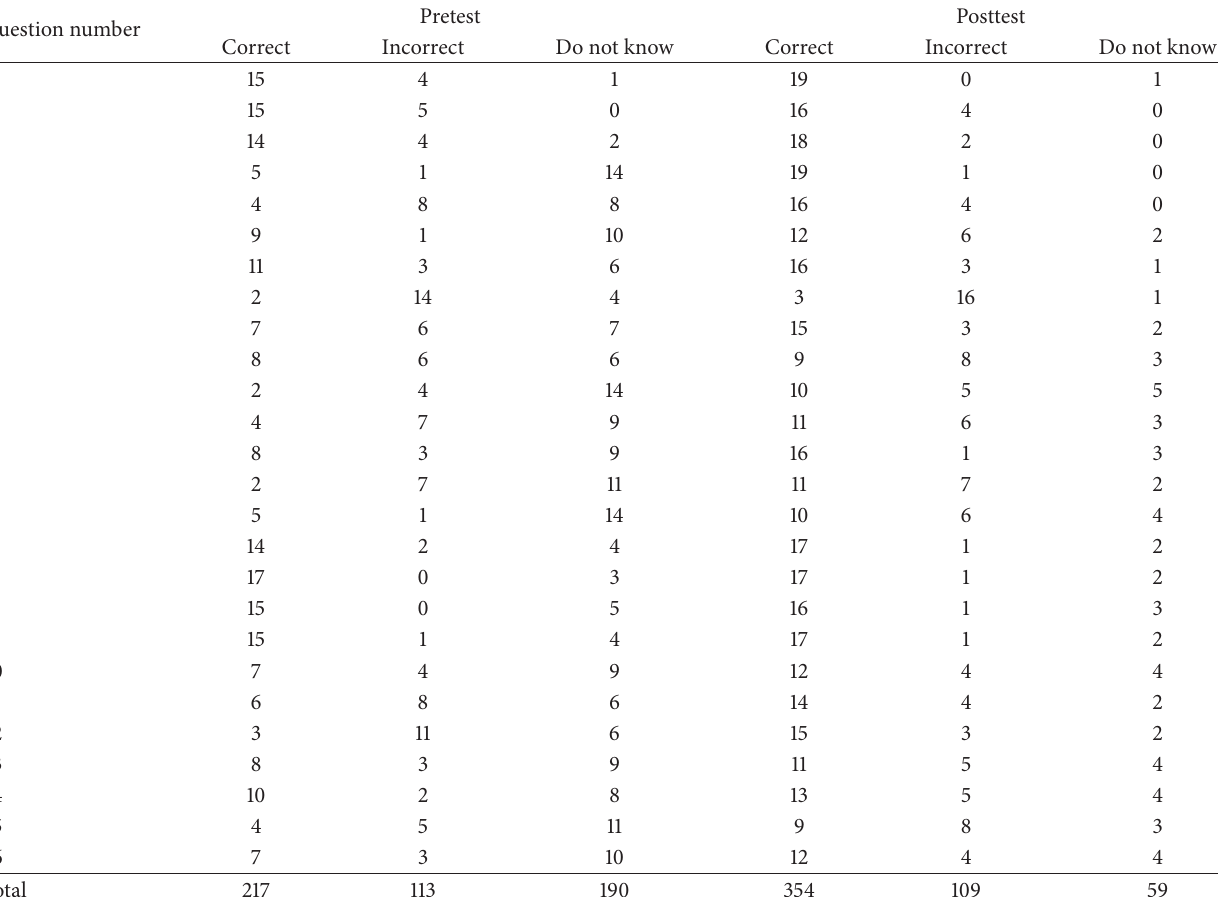
Table 1: Frequency of the answers in the pre- and posttest